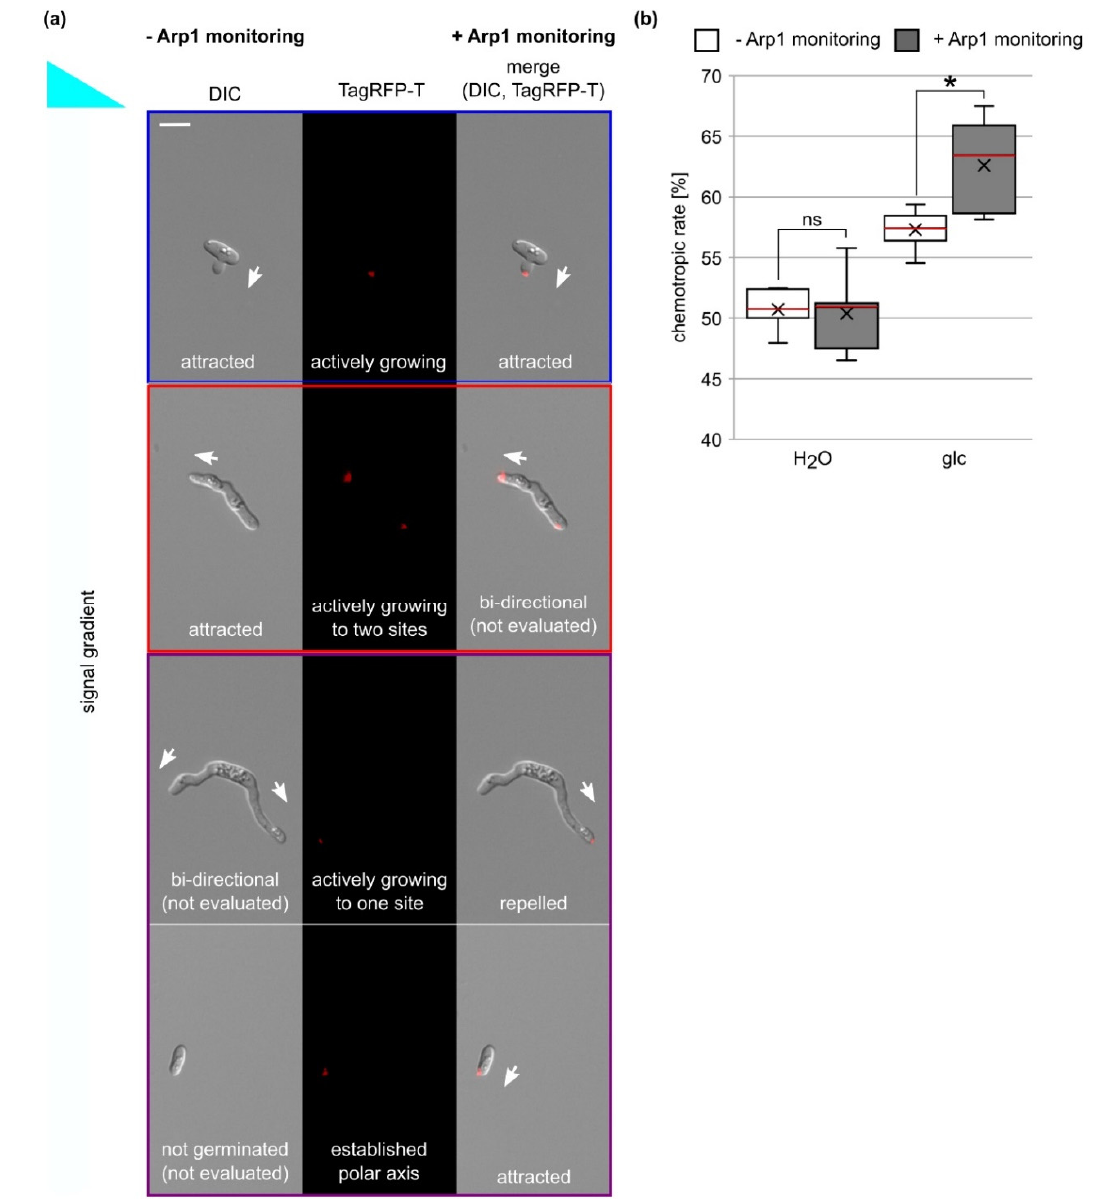
Figure 5. Enhanced evaluation of C. graminicola chemotropic growth by the application of the Arp1 marker: ( a ) the evaluation of growth direction of germlings based on microscopic analyses without ( − ) and with (+) Arp1 monitoring. The tip localization of Arp1-TagRFP-T was used as an indication for active growth or established polar axis. Blue box = same evaluation of results in ( − ) and (+); red box = different evaluation results in ( − ) and (+); violet box = germlings or non-germinated conidia that can be included in the (+) evaluation in contrast to ( − ); size bar = 10 µm. ( b ) The chemotropic rates of germlings to gradients of water (H 2 O) and 50 mM glucose (glc) after incubation for 6 h at 23 °C obtained from experiments without ( − ) and with (+) the monitoring of the fluorescent Arp1 marker. Chemotropic rate: <50% = repulsion; = 50% = no growth reaction; >50% = attraction; meridian is indicated in red; average is indicated by x; n ≥ 5; *, p < 0.05; ns = not significant.